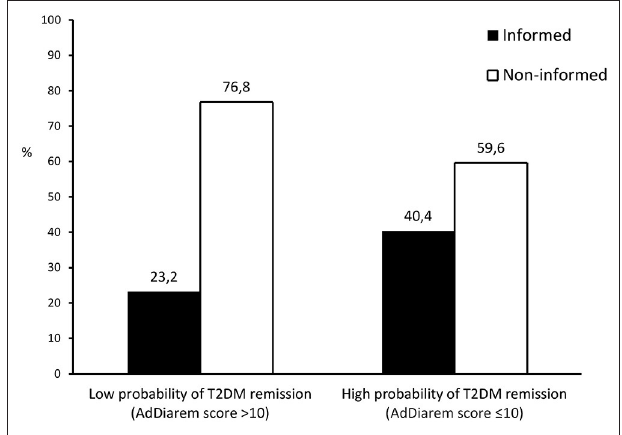
FIGURE 1 | Graphical presentation of the percentage of patients having been informed about the treatment option of metabolic surgery among those with high vs. low probability of T2DM remission within the first 5 years following bariatric surgery, stratified according to the advanced DiaRem[[Inline Image]] score. AdDiarem score, advanced diabetes remission score; T2DM, type 2 diabetes